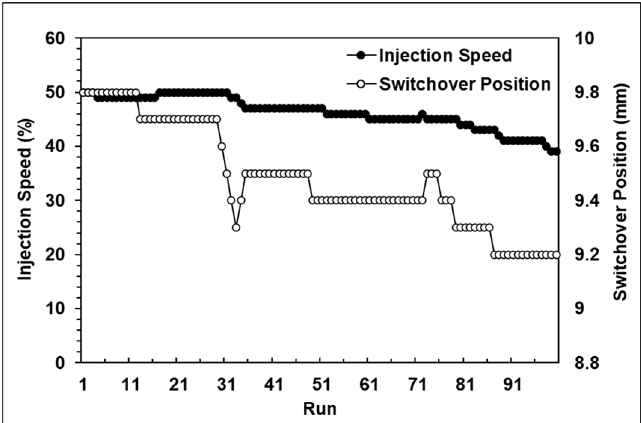
Figure 17. Adjustment process using the adaptive adjustment system .